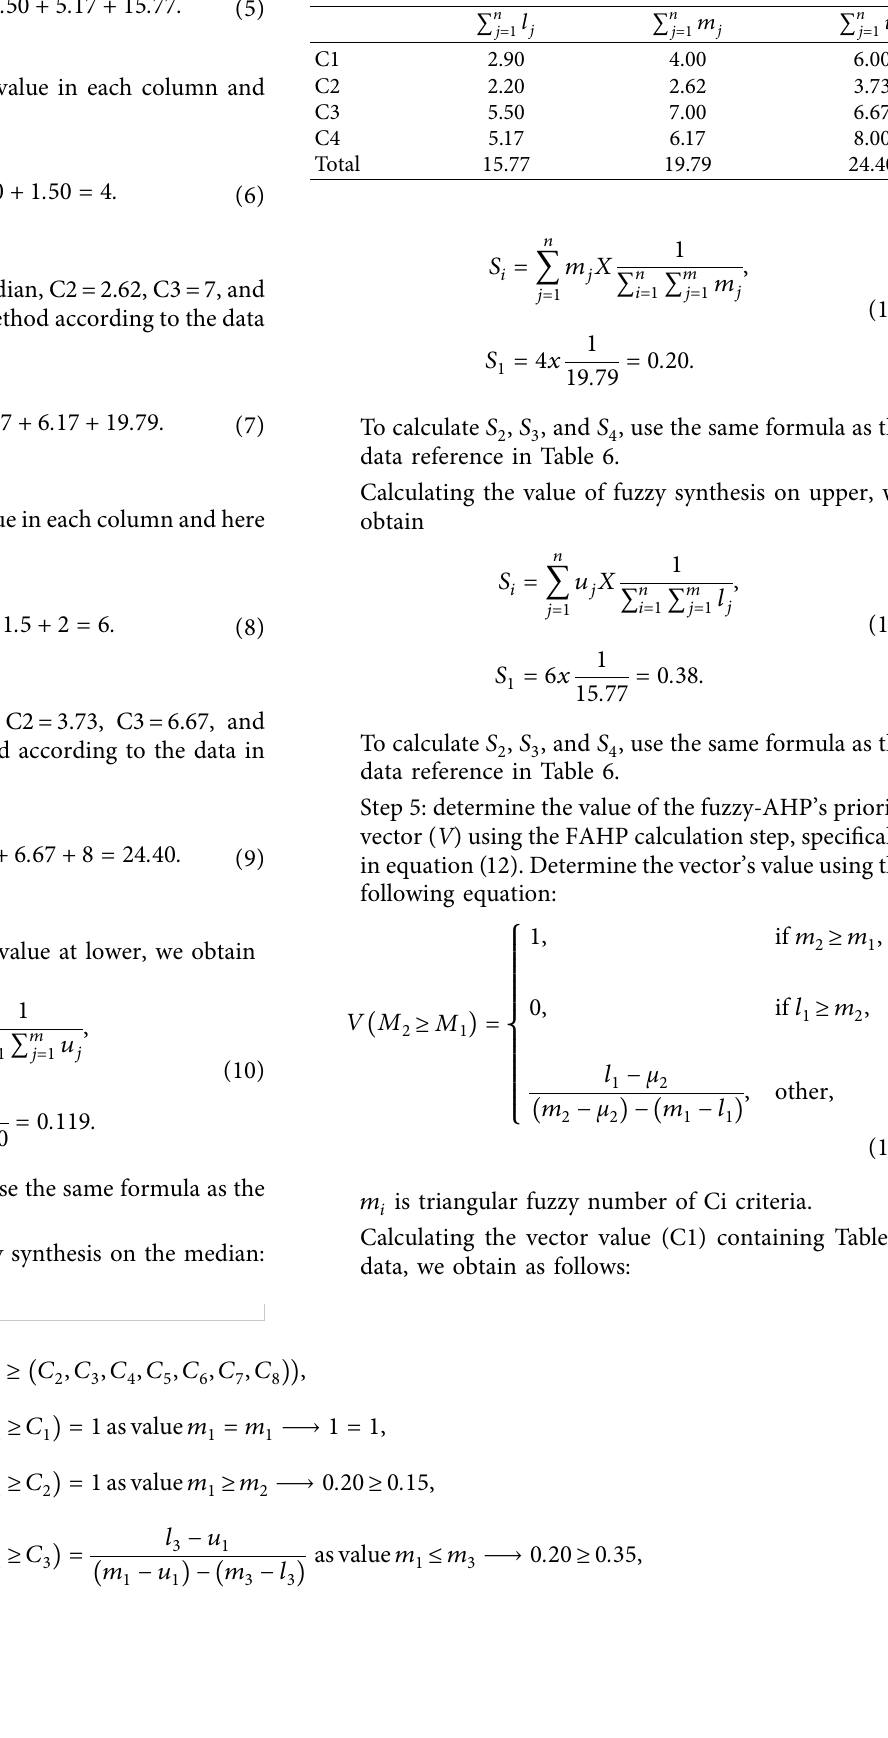
Table 6: Total of lower, median, and upper for each